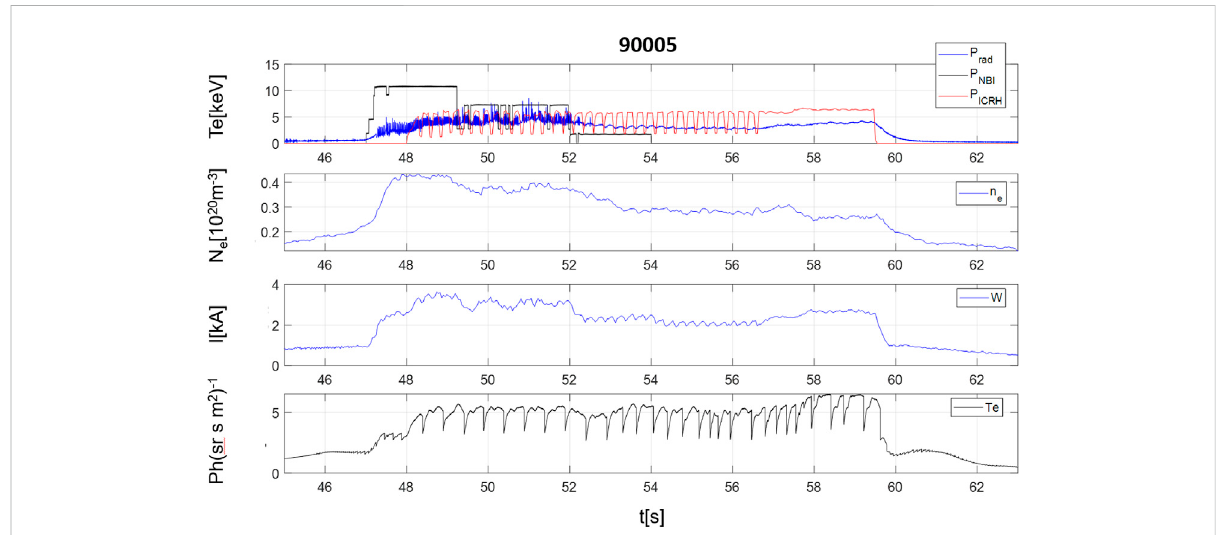
FIGURE 2 TypicalexperimentofsawteethmodulationwithICRHinaJETHmodeplasma.Fromtoptobottom:additionalheatingpowers,centralelectron density, plasma internal energy W, central electron temperature (see Sections 5.2 and